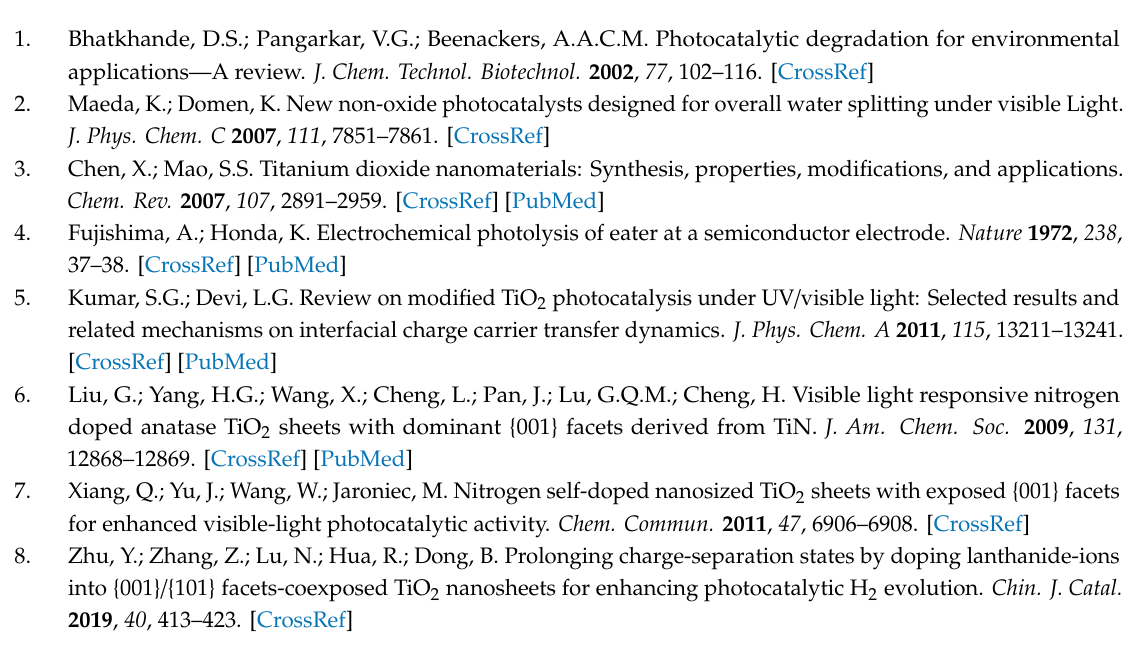
Figure S1: XRD patterns of Ti 3 C 2 and TTC-x. (x = 100, 120, 140 and 160 ◦ C, respectively), Figure S2: UV-vis DRS and plots of ( α hv ) 2 vs hv curves of BPQDs, Figure S3: HRTEM image of black phosphorus nanosheets, Figure S4: Comparison on the photocatalytic e ffi ciency of pristine Ti 3 C 2 and TTC-x composites (10 mg / L MO solution), Figure S5: Cycling degradation curves of MO solution in the presence of BTTC-120 composite, Figure S6: The XRD patterns of used and fresh BTTC-120 sample, Figure S7: The photocatalytic hydrogen evolution rate of Ti 3 C 2 and TTC-x (x = 100, 120, 140 and 160 ◦ C, respectively). Author Contributions: Z.Y. and H.S. (Huajun Sun) conceived and designed the experiments; Z.Y. and X.L. participated in the experiments and measurements; X.L. and H.S. (Huiting Sui) participated in the discussion of the results; Z.Y. and X.L. drafted the manuscript. All authors have read and agreed to the published version of the